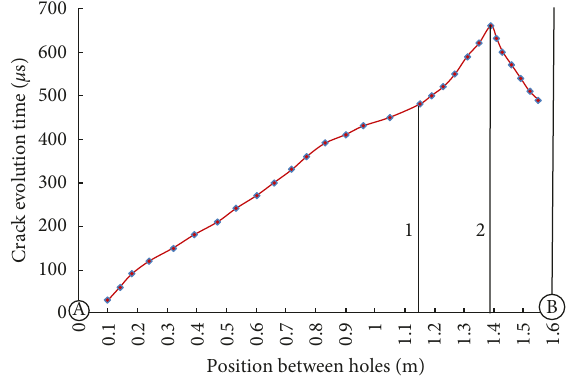
Figure 18: Variation in crack length with time. A is the blasting hole; B is the empty hole; line 1 indicates the boundary between initial crack zone and secondary crack zone; line 2 represents the position where secondary cracks meet the tensile cracks induced by reflected stress